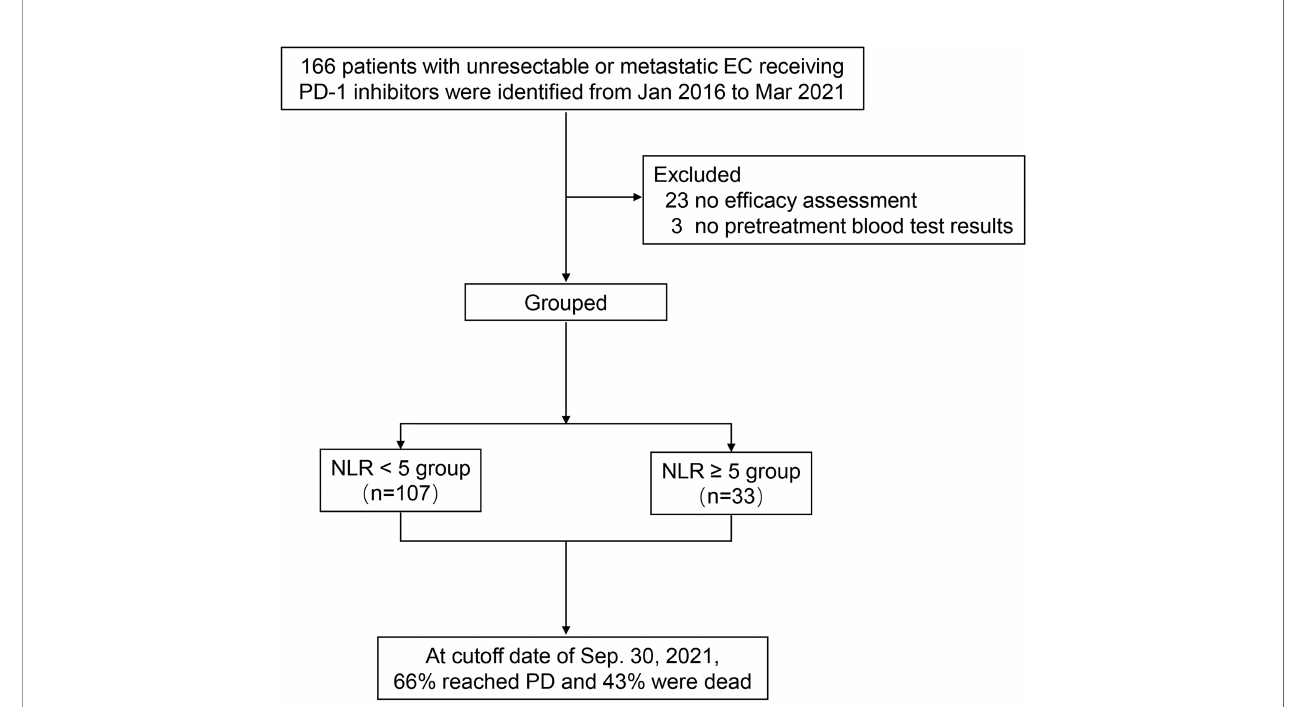
FIGURE 1 | Diagram of the